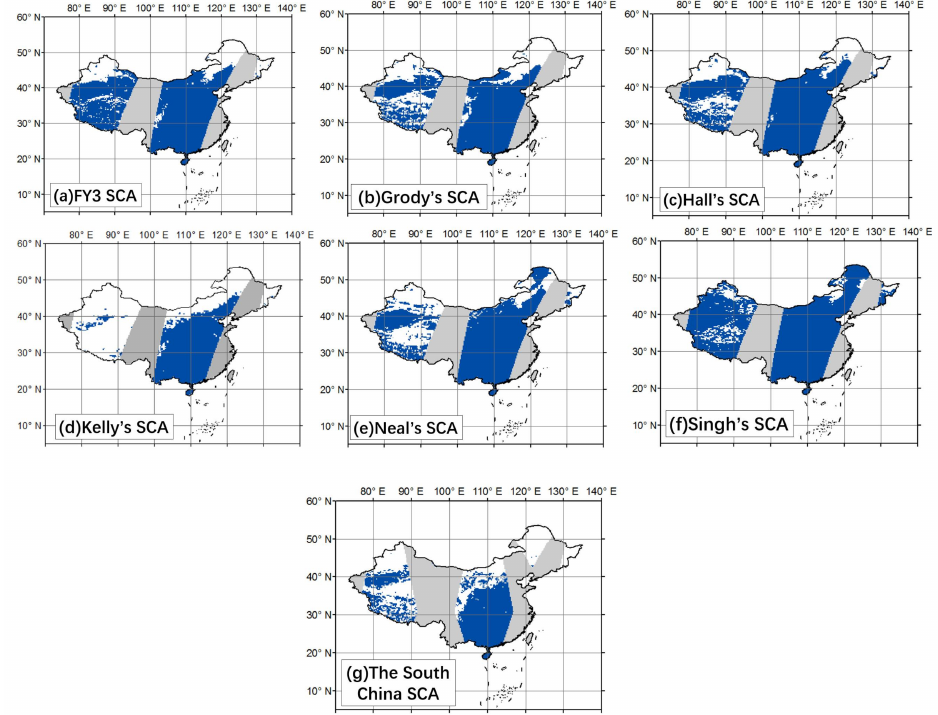
Figure 2. Comparison of PMW SCA maps for 7 January 2014: ( a ) FY SCA map, ( b ) Grody’s SCA map, China SCA map. (blended SCA image ( g ) using both ascending and descending data for the South China algorithm and descending SCA images( a – f ) for the remaining PMW SCA mapping